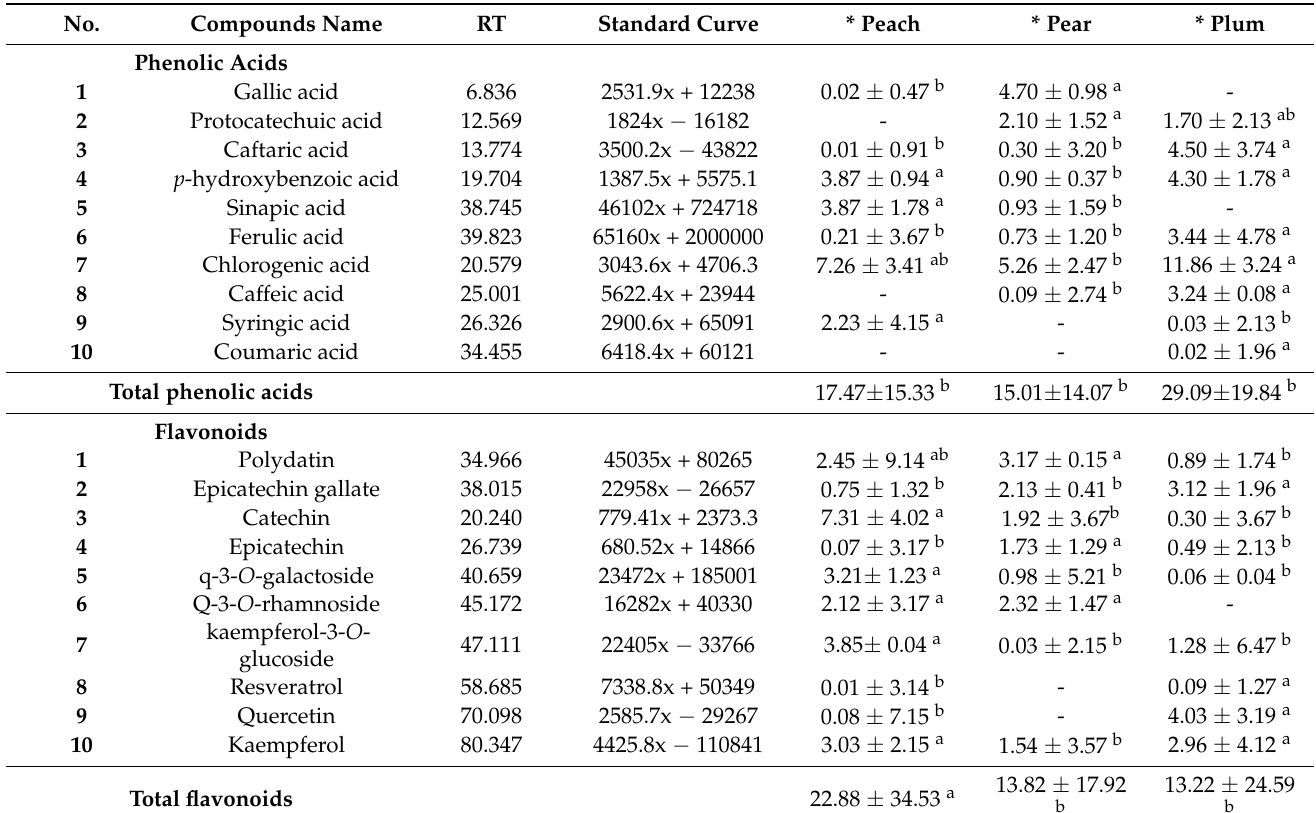
Table 3. Major polyphenol concentrations (mg/100 g of F.W ) in the flesh of studied